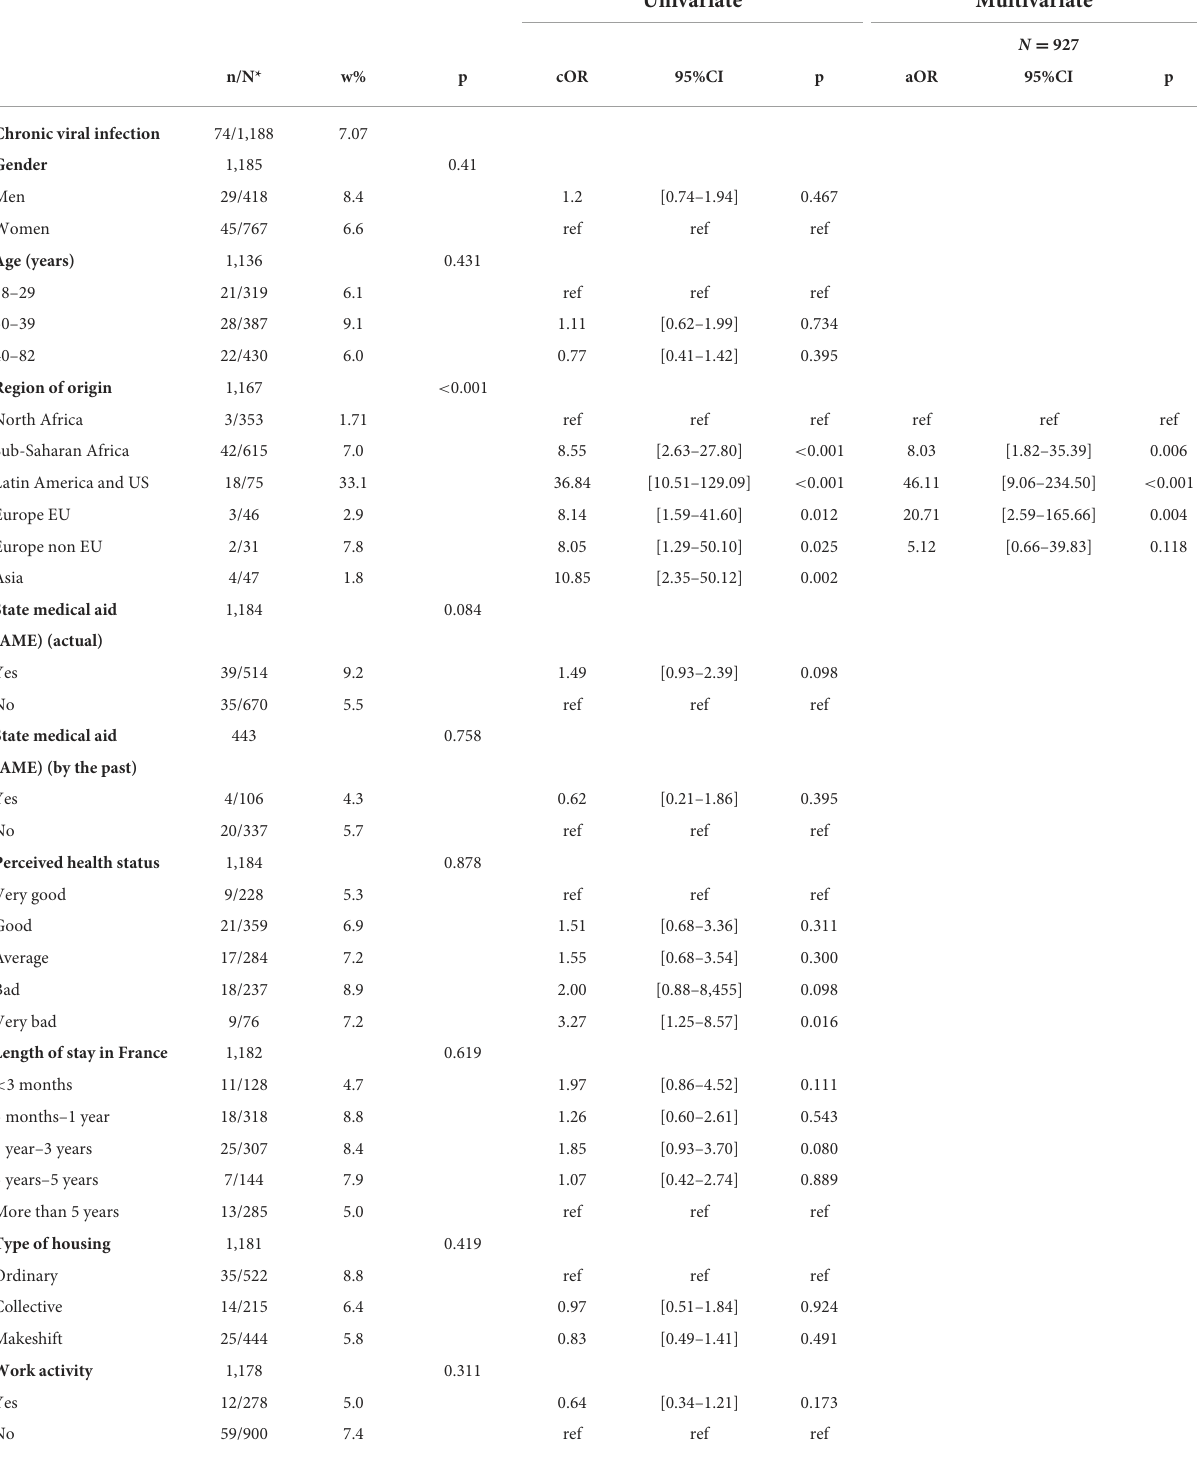
TABLE 3 Reported prevalence of chronic viral infections (HIV, HBV, or HCV infection) among undocumented migrants in Paris and Bordeaux, univariate and multivariate analyses with backward stepwise logistic regression ( p = 0.05 threshold), Premiers Pas survey ( n = 1,188). Univariate Multivariate N =